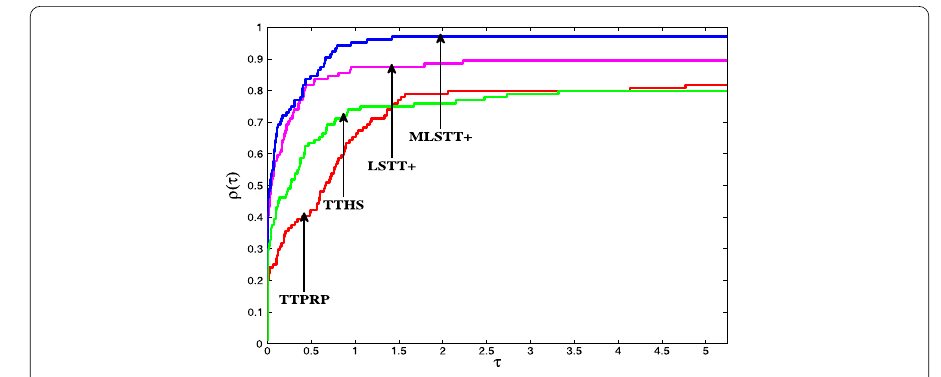
Figure 2 Performance profiles on NF of four CG methods